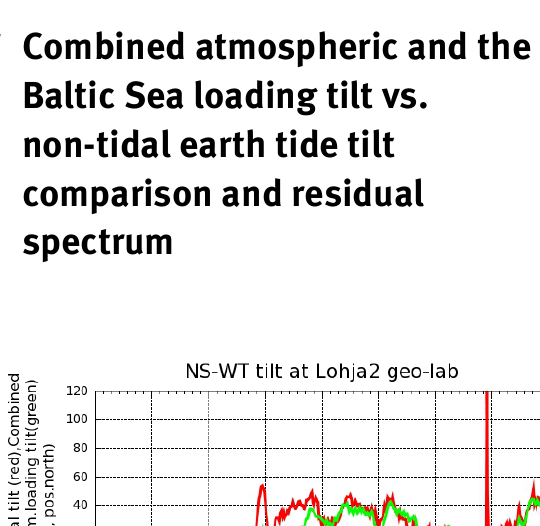
Figure 6: Amplitude spectrum of non-tidal residual tilt of the NSWT tiltmeter corrected by combined loading model tilts of the Baltic Sea and